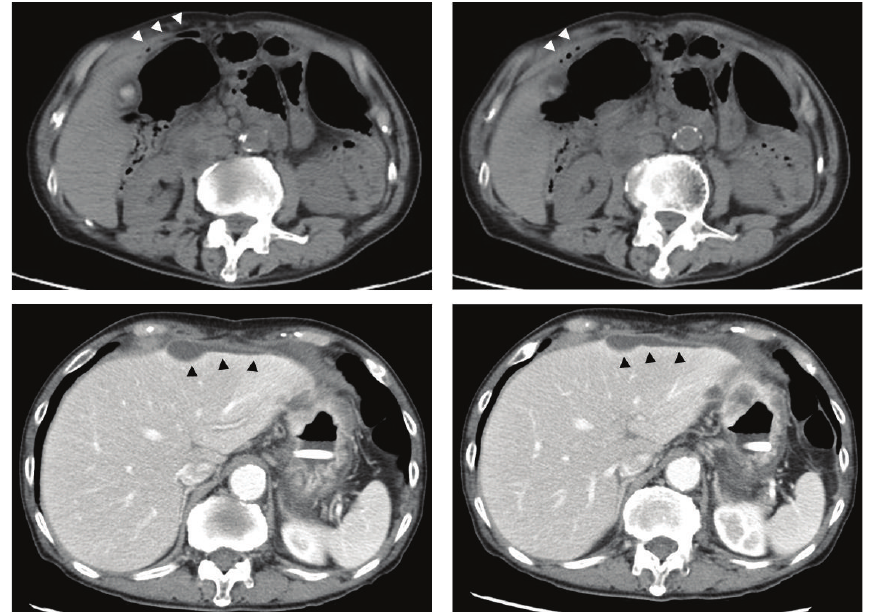
Figure 2: Computed tomography of abdomen and pelvis, showing abnormal pneumoperitoneum (white arrowhead) and limited ascites (black arrowhead).